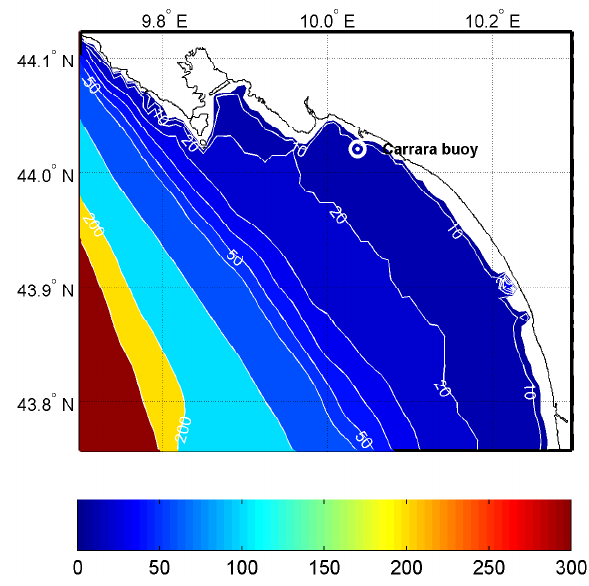
Fig. 3. Bathymetry and position of the Carrara buoy